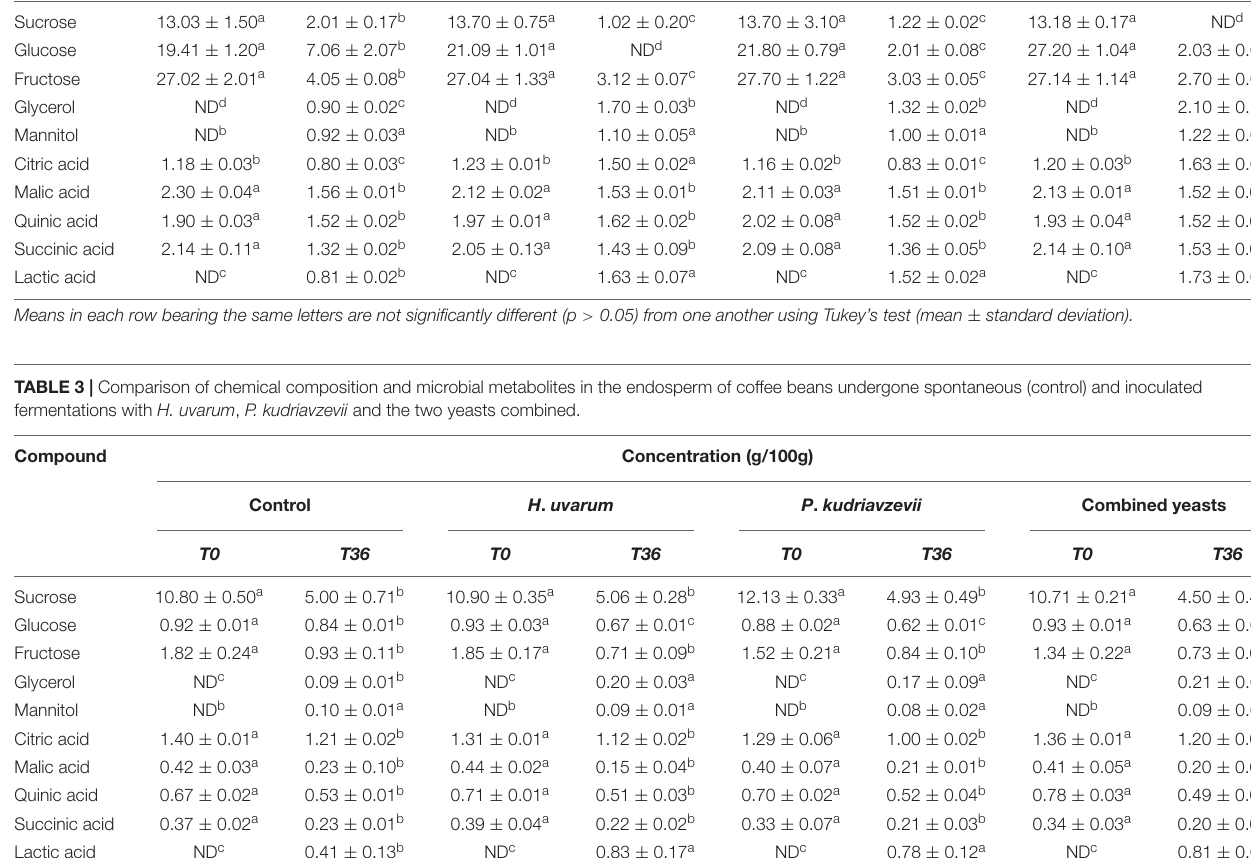
TABLE 2 | Comparison of chemical composition and microbial metabolites in the mucilage of coffee beans undergone spontaneous (control) and inoculated fermentations with H. uvarum , P. kudriavzevii , and the two yeasts combined. Compounds